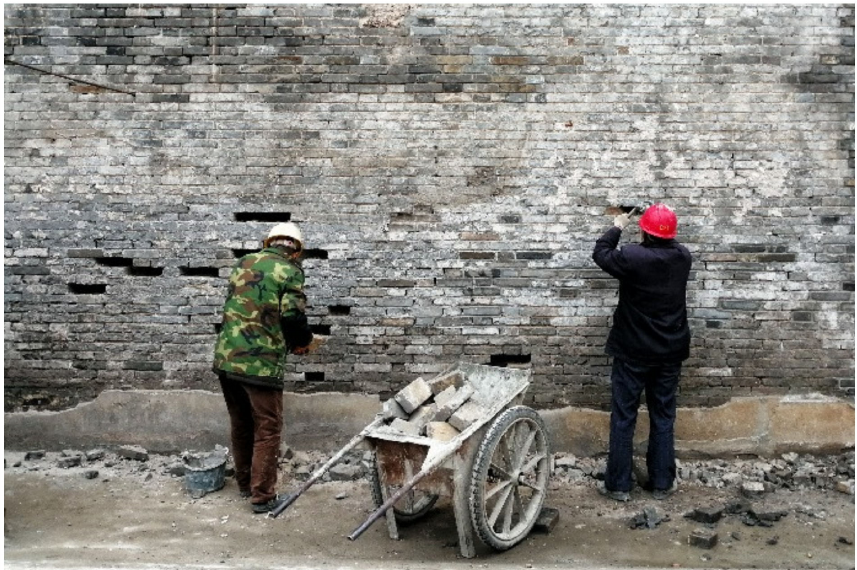
Figure 22. Restore the exterior walls with different methods according to the damage degree of the